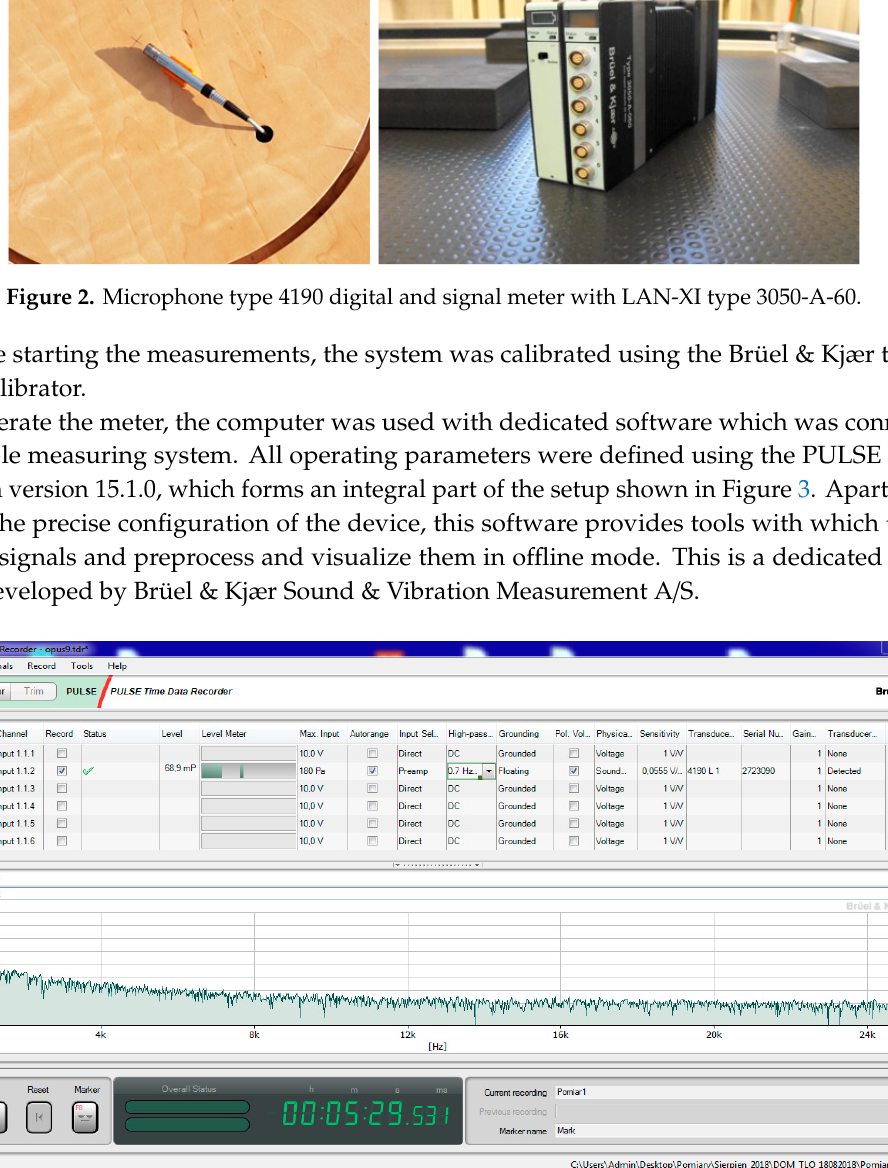
Figure 3. PULSE LabShop application screenshot.